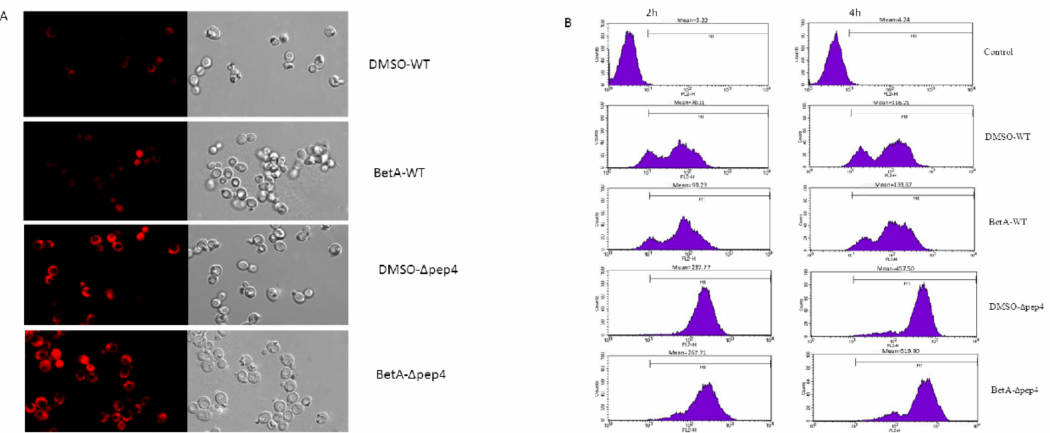
Figure 6. BetA induced generation and accumulation of ROS for diferent yeast strains. ( A ) 1 × 10 7 cells were incubated with 20 µ g / mL BetA for 4 h subsequently analyzed for ROS accumulation by DHE staining with laser scanning confocal microscope. Bar, 5 mm. ( B ) 1 × 10 7 cells were incubated with 20 µ g / mL BetA for 2 h or 4 h, subsequently analyzed for ROS accumulation by flow